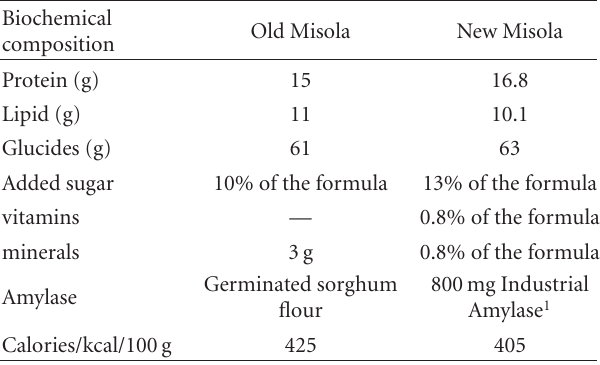
Table 3: Biochemical composition of Old Misola (OM) and new Misola (NM) produced at Saint Camille Medical